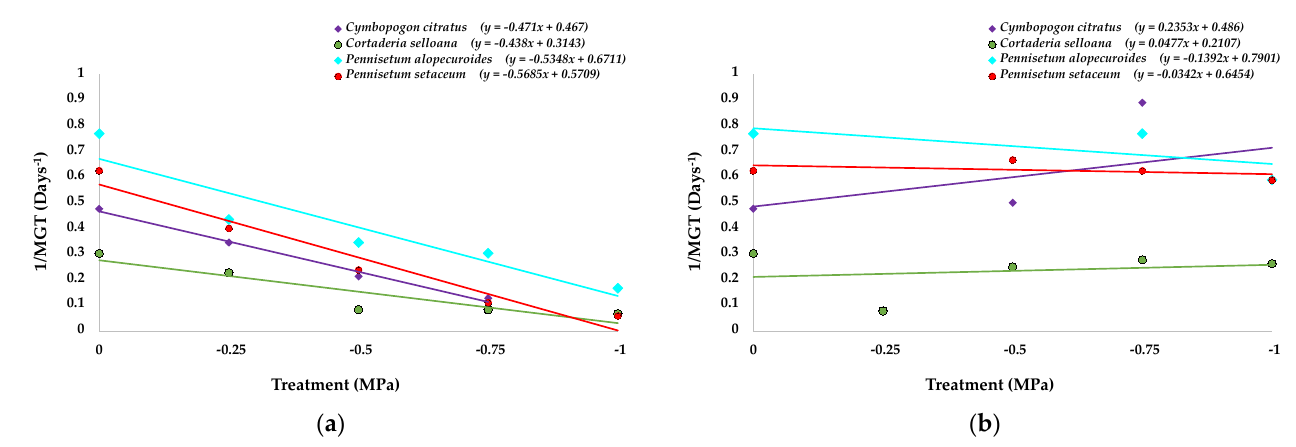
Figure 5. Germination velocity (1/MGT), in relation to the osmotic potential of the germination medium, generated by PEG addition, for the four analysed species, ( a ) for the PEG ‐ treated seeds in the 30 ‐ day initial germination tests, ( b ) after 20 days of “recovery”. Control: germination in distilled water.